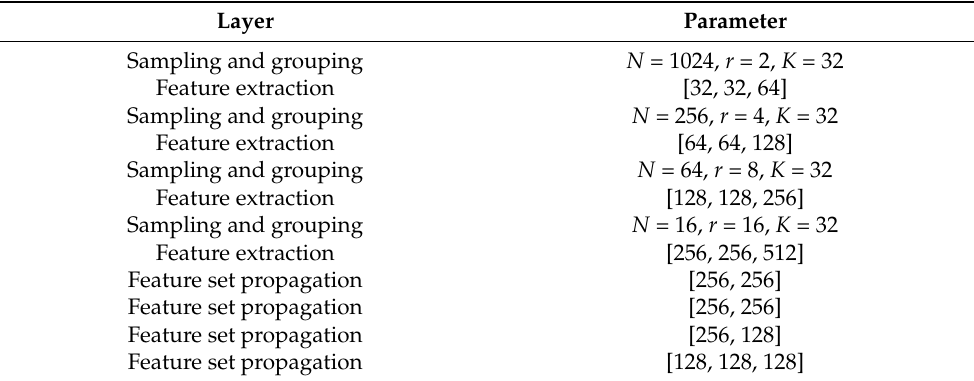
Table 1. Redesigned hyper-parameters in PointNet++ for urban light detection and ranging (LiDAR) point clouds.